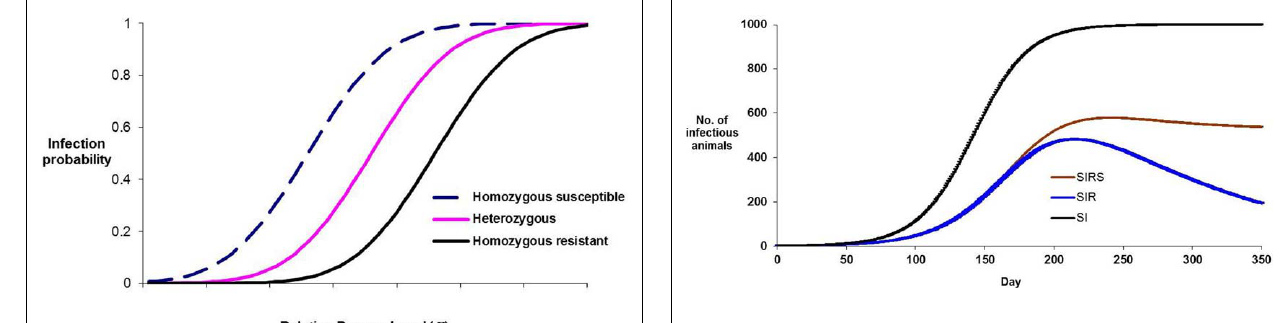
FIGURE 2 | Numbers of infectious animals during the course of an hypothetical epidemic, for three modes of transmission of infection, (i) SI model in which infected animals remain infectious, (ii) SIR model in which infected animals recover so that they are no longer infectious and remain immune to the infection, (iii) SIRS model in which recovered animals lose their immunity and become immunologically susceptible again. Non-zero parameter values are identical for each model. Population size is 1000